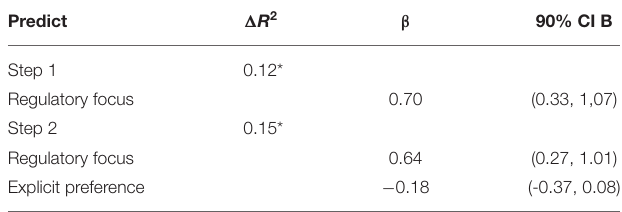
TABLE 1 | Results of the regression analysis predicting information